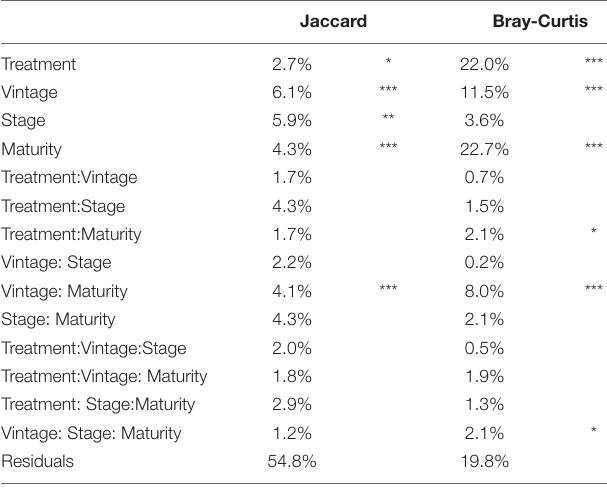
TABLE 2 | Percentage of variance explained by Treatment (Without SO 2 and SO 2 ), Stage, Vintage, Maturity factors and the interactions for different β -biodiversity indices. Jaccard